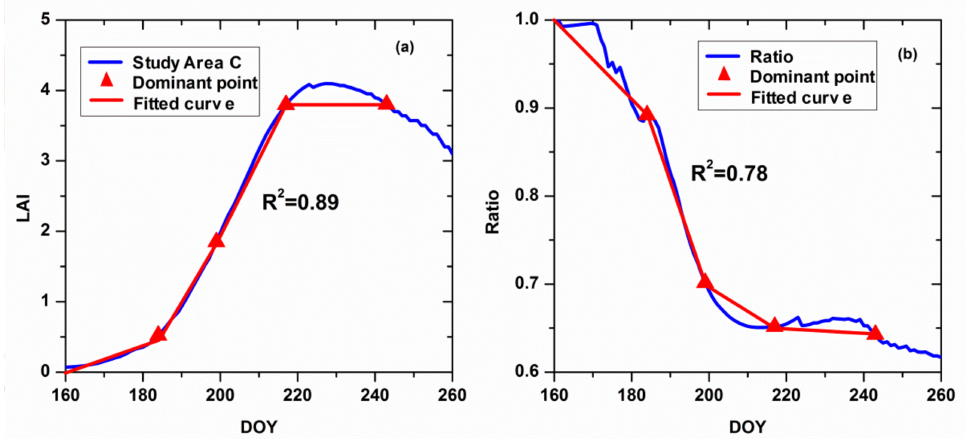
Figure 10. Assessment of the accuracy for the four dominant points. ( a ) shows the the fitted results